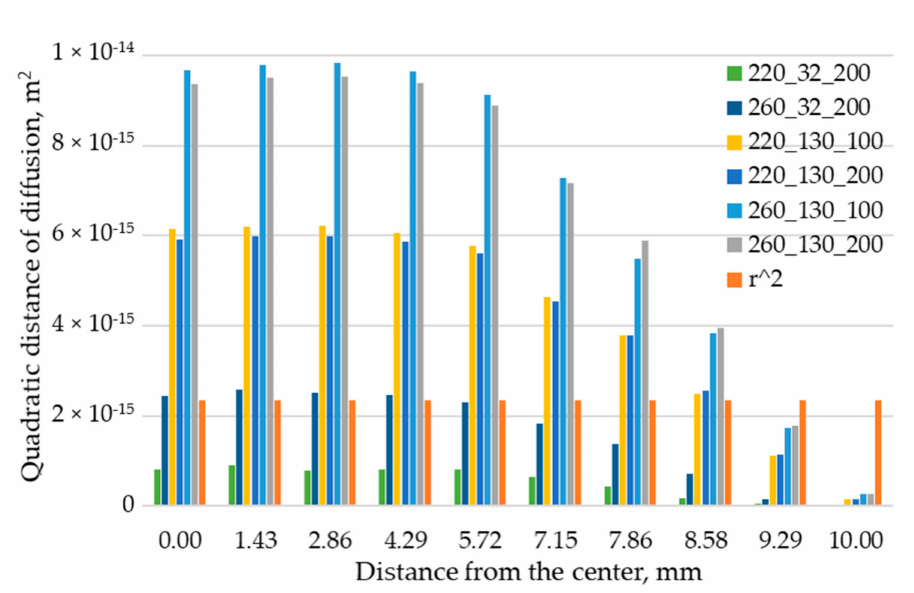
Figure 11. Gradient of the quadratic distance of di ff usion for specimens produced with di ff erent interface temperature